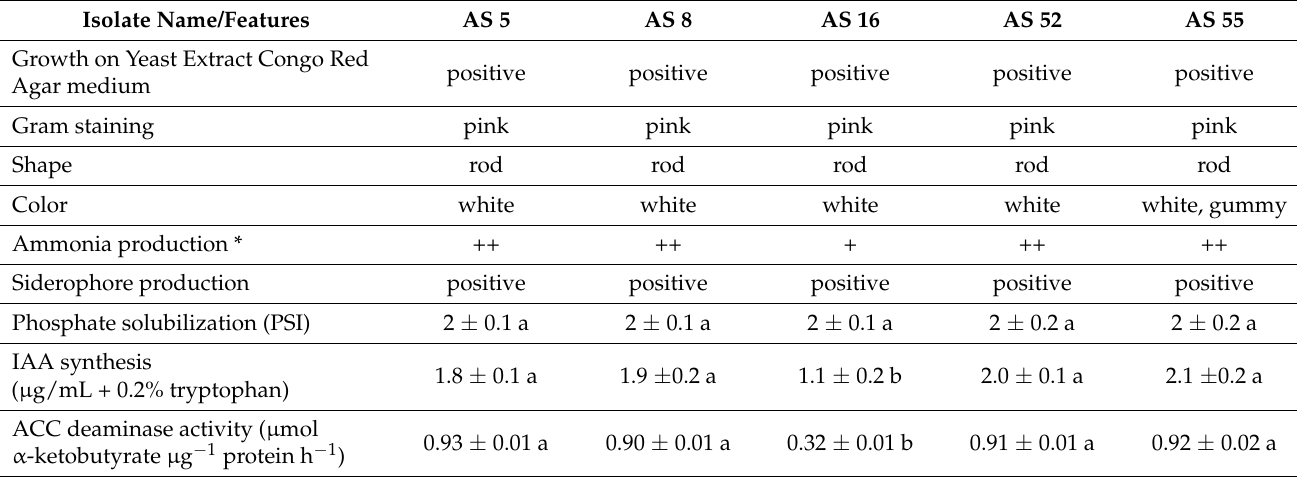
Table 2. Characteristics of rhizobial